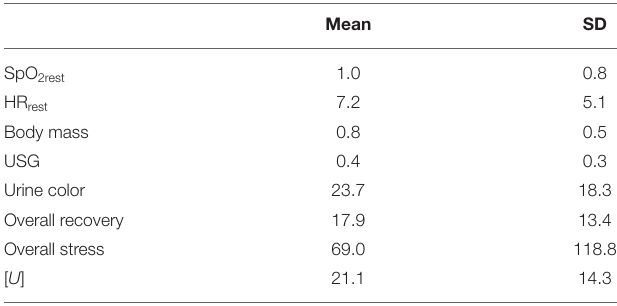
TABLE 2 | Mean and standard deviation (SD) within-subject coefficient of variation (CV, in %) for the daily